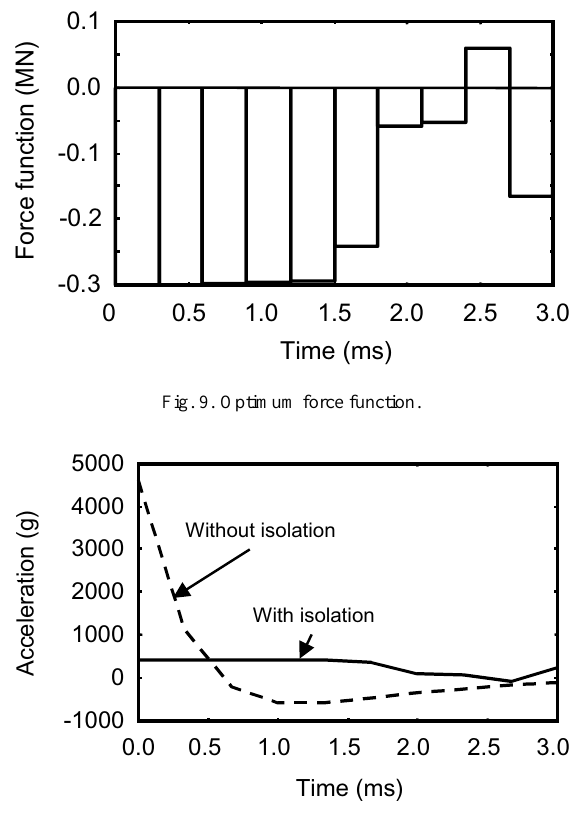
Fig. 10. Time histories of accelerations of the human body with and without